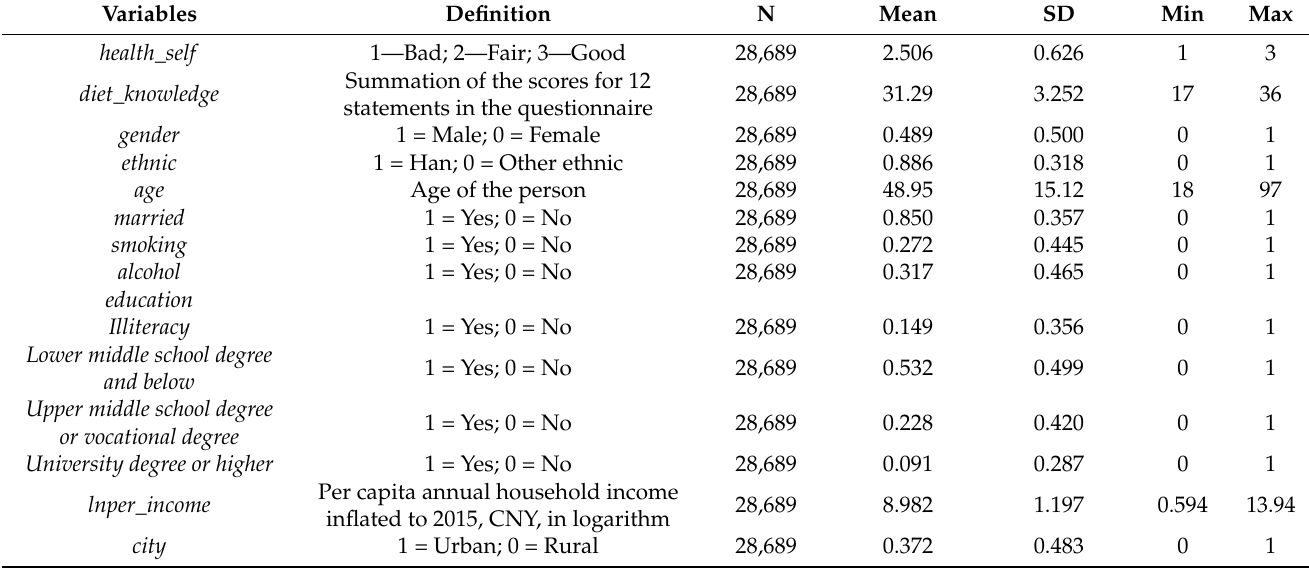
Table 1. Summary statistics of the analytical